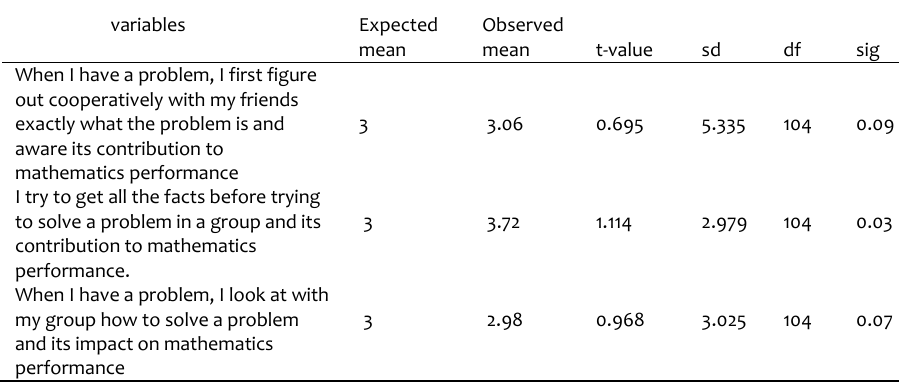
Table 1: Perception of students on cooperative problem-solving & their performance